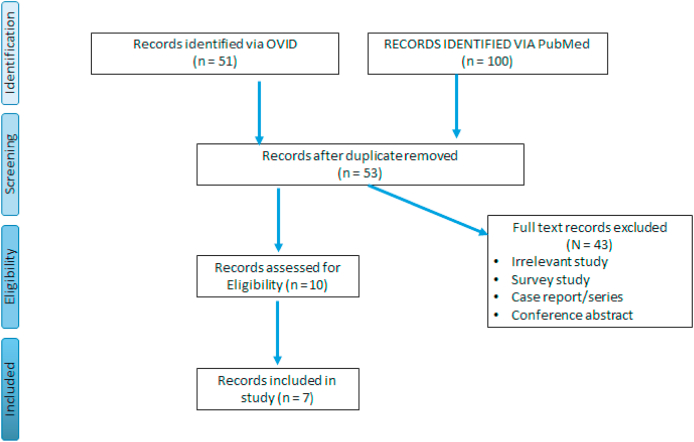
PRISMA flow chart.